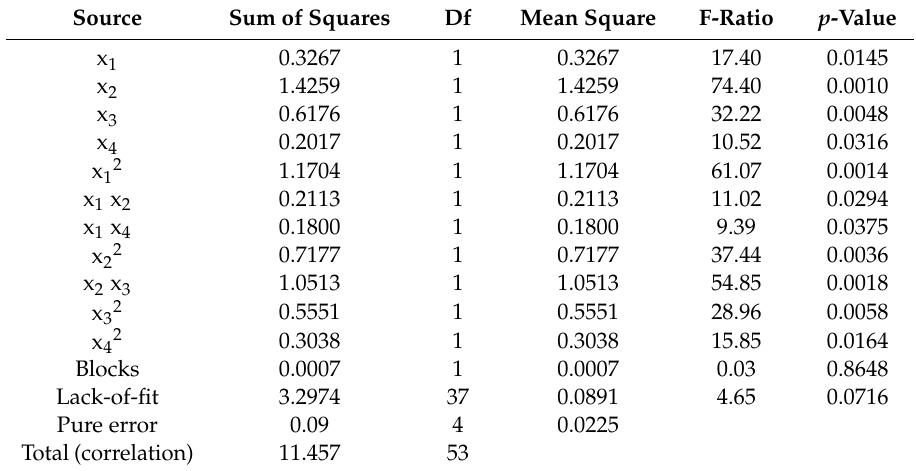
Table 7. Analysis of variance: the empirical model predicting the sensory quality of beer. Source Sum of Squares Df Mean